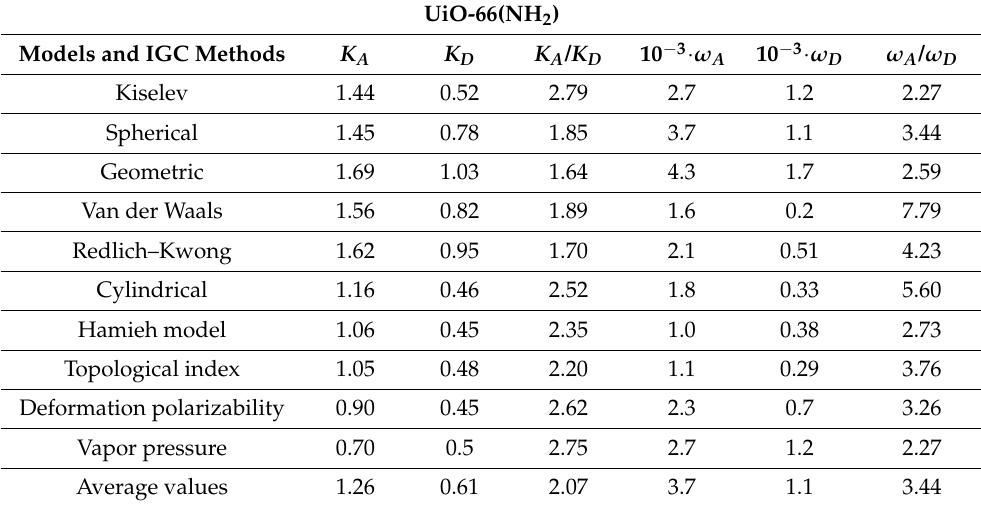
Table 9. Values of the enthalpic acid–base constants K A and K D (unitless) and the entropic acid–base constants ω A and ω D (unitless) of UIO-66(NH 2 ) catalyst and their acid–base ratios for the different used molecular models and IGC